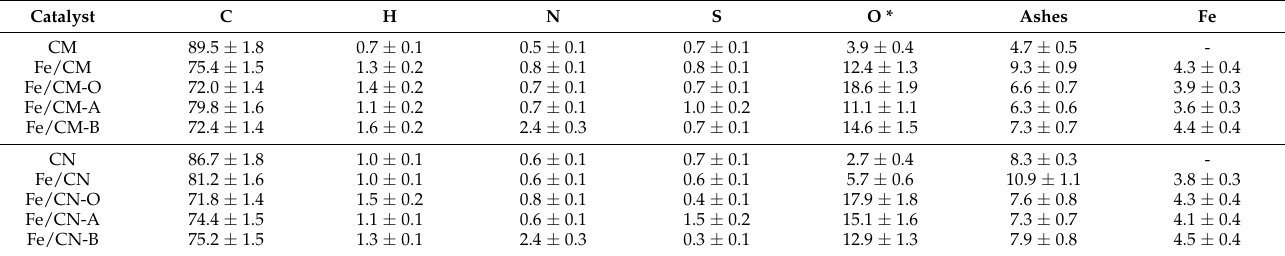
Table 2. Elemental analysis of Fe/AC- f and raw AC (%, w / w , d.b.).